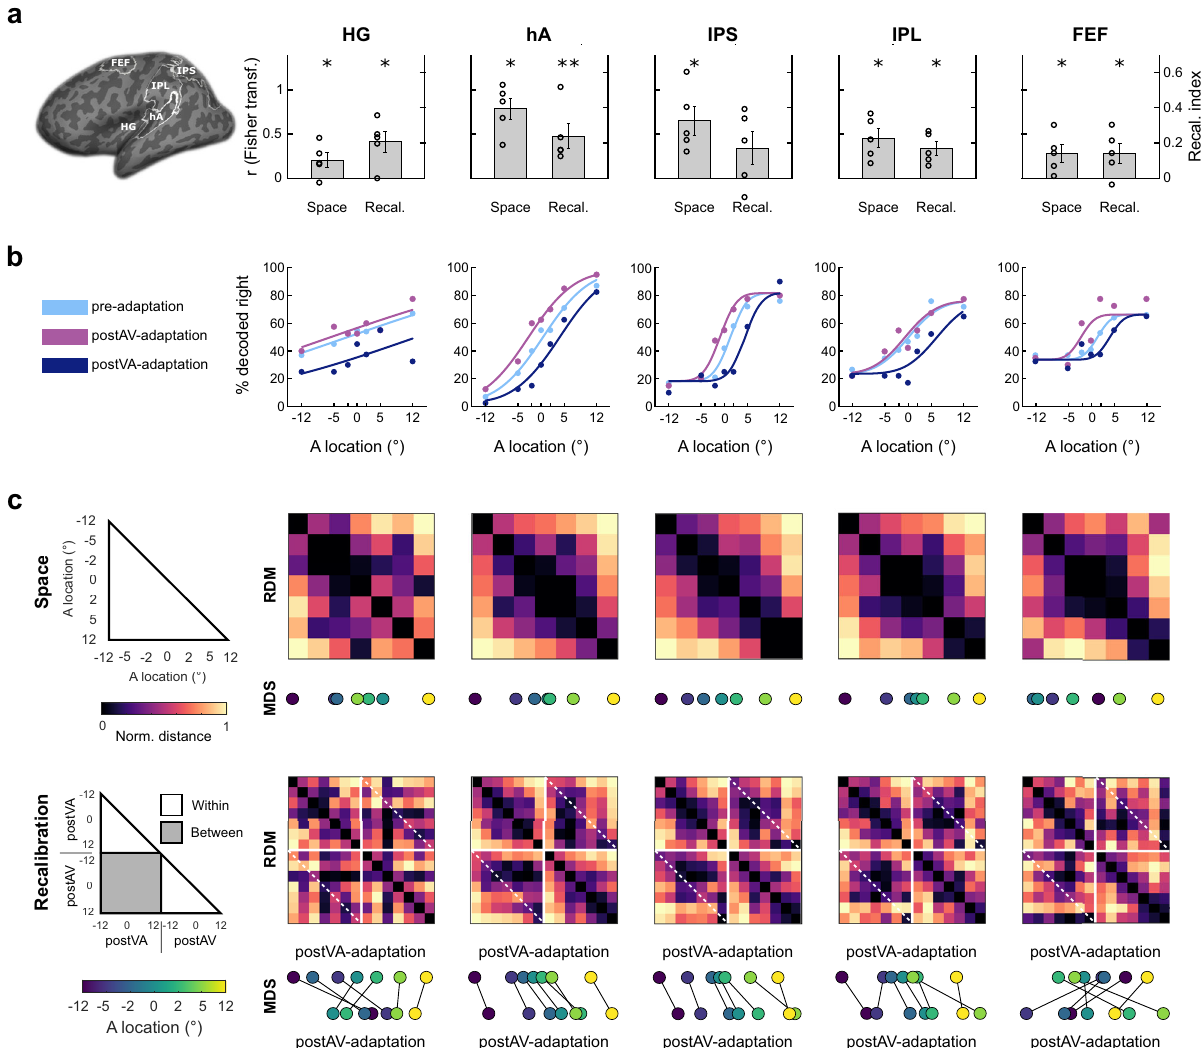
Fig. 3 fMRI multivariate decoding and representational dissimilarity matrices. a Across-subjects ’ mean (±SEM, n = 5 subjects) spatial encoding index (left bars, Fisher z-transformed correlation coef fi cient) and across-subjects ’ mean (±SEM, n = 5 subjects) recalibration index (right bars, difference in fraction ‘ decoded right ’ (i.e. positive azimuth) for postAV-adaptation vs. postVA-adaptation) in the ROIs as indicated. FDR-corrected one-tailed p -values from one-sample bootstrap-based t -tests for spatial encoding index: HG: p = 0.028; hA: p = 0.020; IPS: p = 0.020; IPL: p = 0.020; FEF: p = 0.024; and recalibration index: HG: p = 0.042; hA: p = 0.010; IPL: p = 0.025; FEF: p = 0.046; IPS: p = 0.086. Asterisks denote alpha level * p ≦ 0.05, ** p ≦ 0.01. The individual data points are overlaid as black circles. b Neurometric function fi tted to the fMRI decoded sound locations across ROIs for pre-, postVA- and postAV-adaptation phases. c RDMs (across-subjects ’ mean) showing the Mahalanobis distances for the fMRI decoded sound locations across ROIs. Top row: 7 × 7 RDM for pre-adaptation phase. Bottom row: 14 × 14 matrix for postVA- and postAV-adaptation. The drawings on the left indicate the organization of the RDMs of spatial locations for pre- (top) as well as for postAV- and postVA-adaptation phases (bottom). Using MDS we projected each RDM onto a single dimension (i.e. representing space along the azimuth). For illustration purposes, we vertically offset the MDS projections for postVA- and postAV-adaptation phases and connected the projections corresponding to the same physical stimulus locations. The MDS results show that the projected locations of the postVA-adaptation phase are shifted towards the left in relation to those of the postAV-adaptation phase particularly in hA and IPS, while a more complex relationship arises in IPL and FEF. HG Heschl ’ s gyrus, hA higher auditory cortex, IPL inferior parietal lobule, IPS intraparietal sulcus, FEF frontal eye- fi eld, RDM representational dissimilarity matrix, MDS multidimensional scaling, FDR false discovery rate. Source data are provided as a Source Data fi